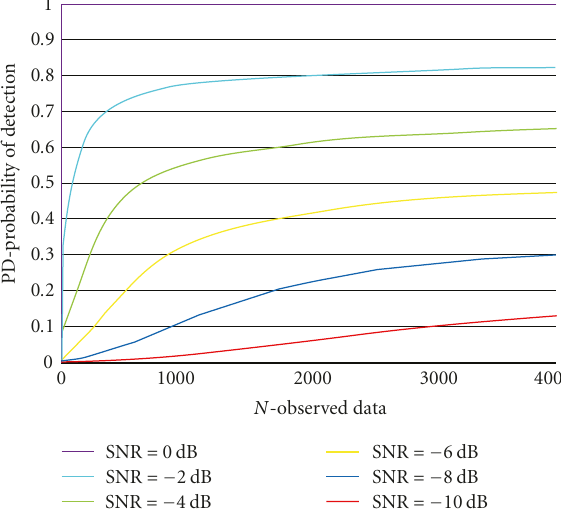
Figure 5: Probability of detection against number of sample for various SNR.